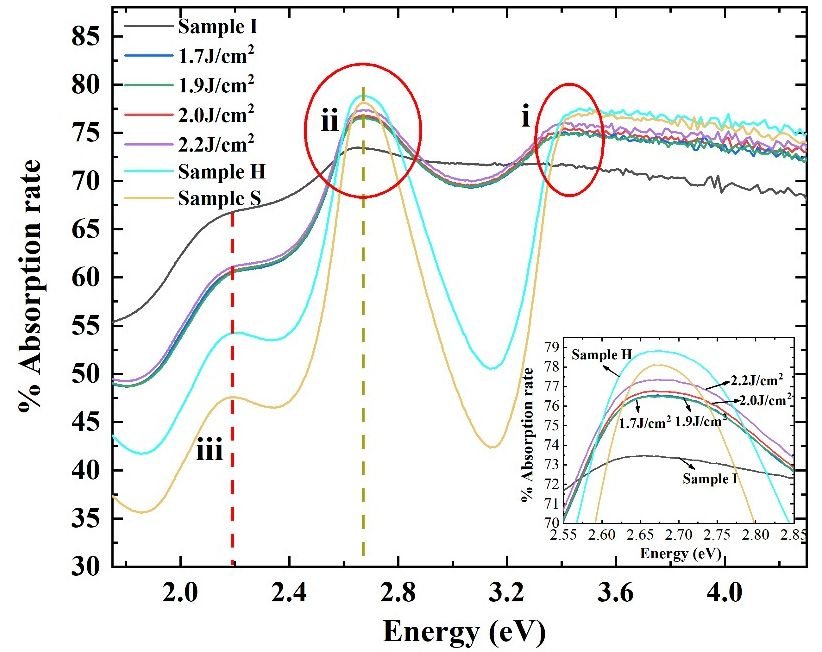
Figure 2. Absorption spectra of four selected 4H-SiC samples measured at room temperature. They are n-type 4H-SiC substrate (S-solid yellow line), P + ions implanted sample (I-solid black line), laser-annealed samples at different energy densities (Ls), and high-temperature annealed sample (H-solid cyan line): ( ⅰ ) represents absorption from valence band to conduction; ( ⅱ ) from donor level or lowest conduction band to higher conduction band; ( ⅲ ) from the defect states. The inset is an enlarged view of the absorption peak ( ⅱ ).